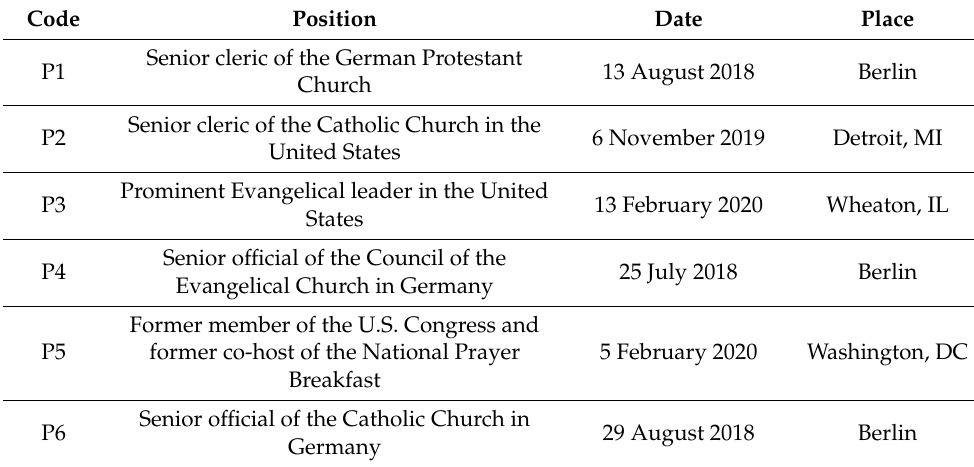
Table A1. List of